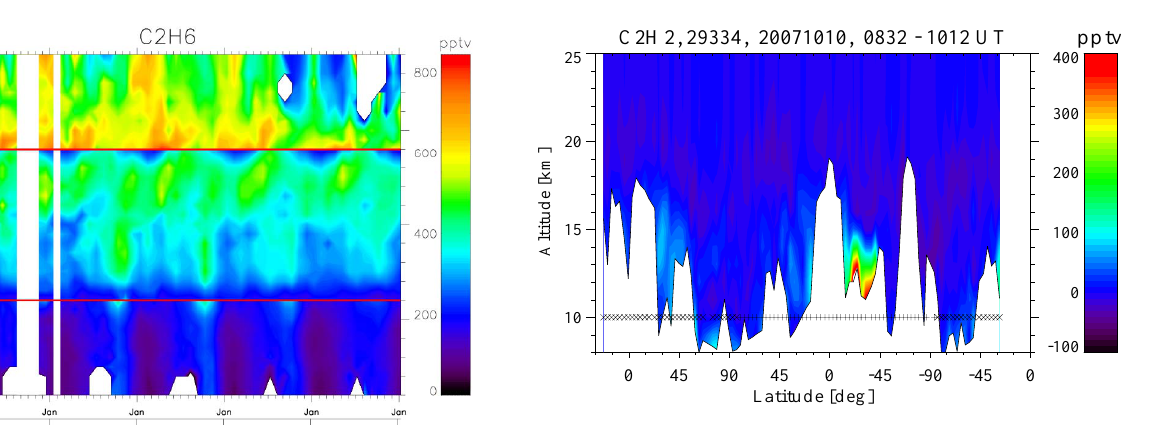
Fig. 12. As Fig. 9 but for C 2 H 2 .